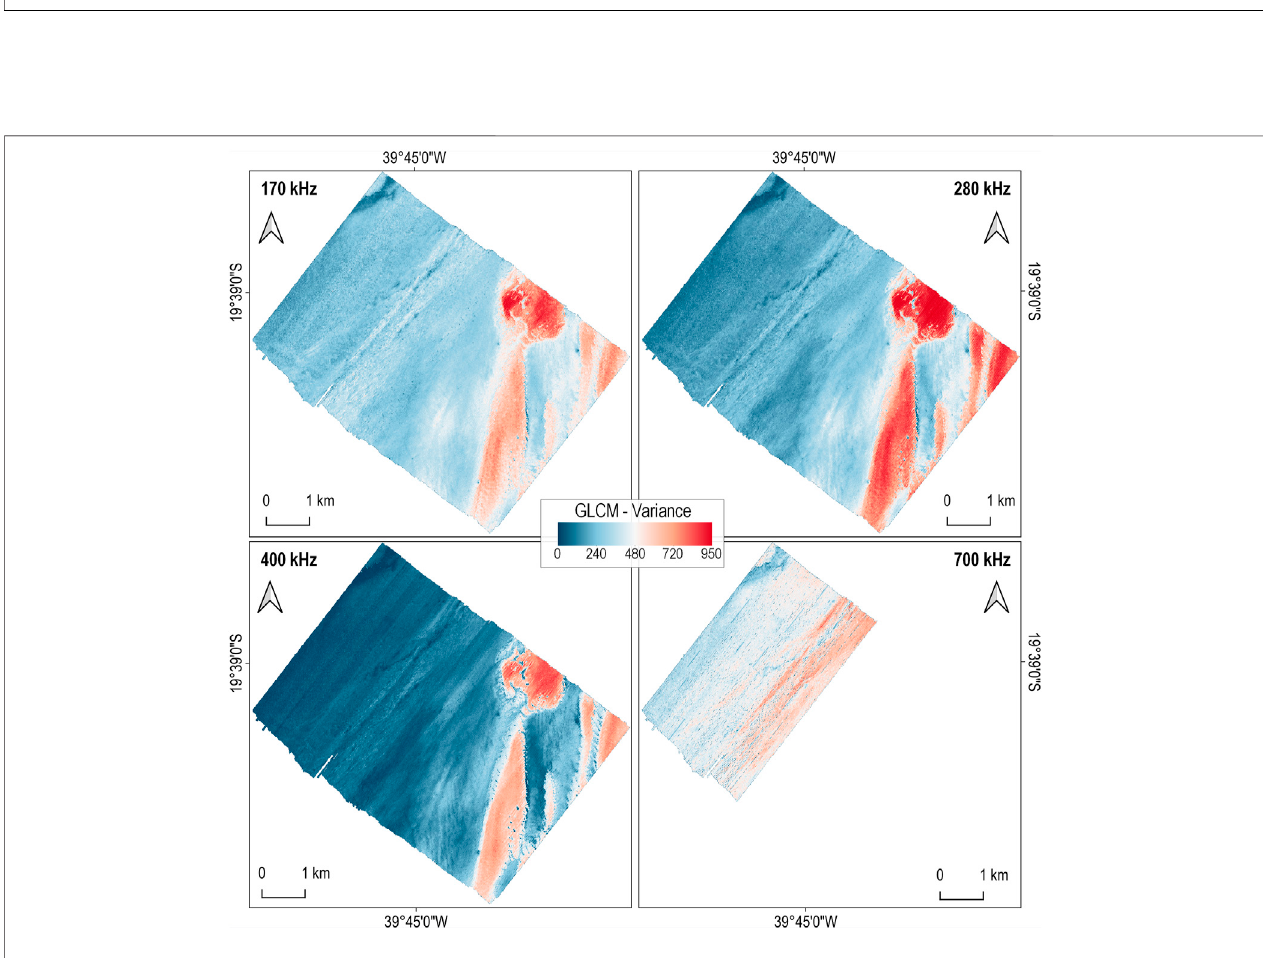
FIGURE 10 | GLCM variance results for each frequency.